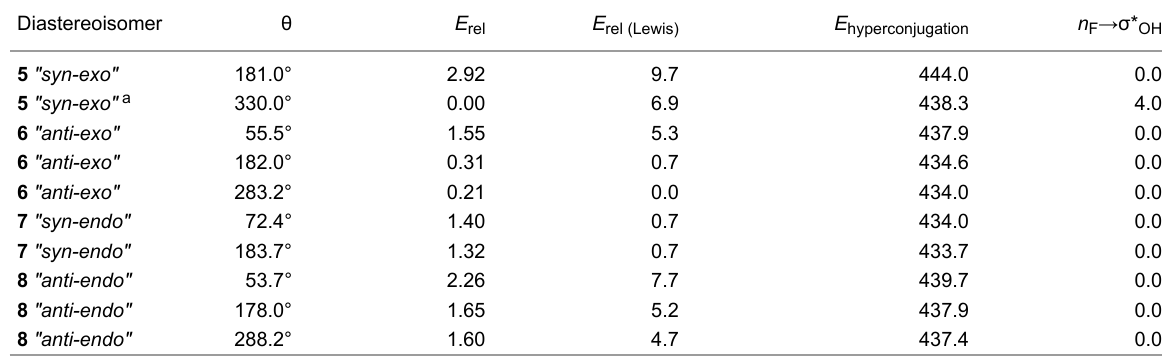
Table 1: H–O–C–C(CF) dihedral angle ( θ , in deg), relative energies, relative Lewis type energies, hyperconjugative energies, and n F →σ * OH inter- action energies (in kcal mol − 1 ).